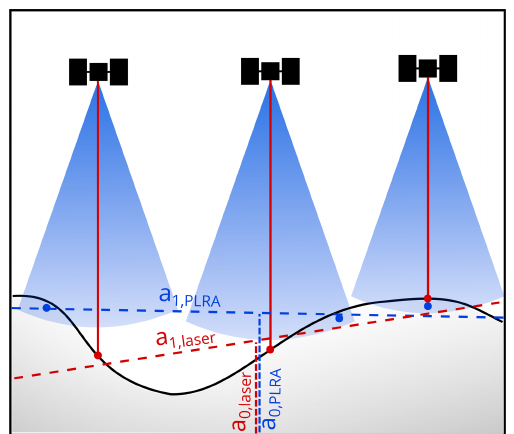
Figure 3. Illustration of the technique-dependent topographic sam- pling. The laser (red) measures the surface elevation in the nadir of the instrument, while for radar altimetry (blue) the first return signal originates from the POCA (marked by the blue point). Hence, pla- nar surface approximations to the measured heights (dashed lines) as in Eq. (2) are intrinsically different for the different